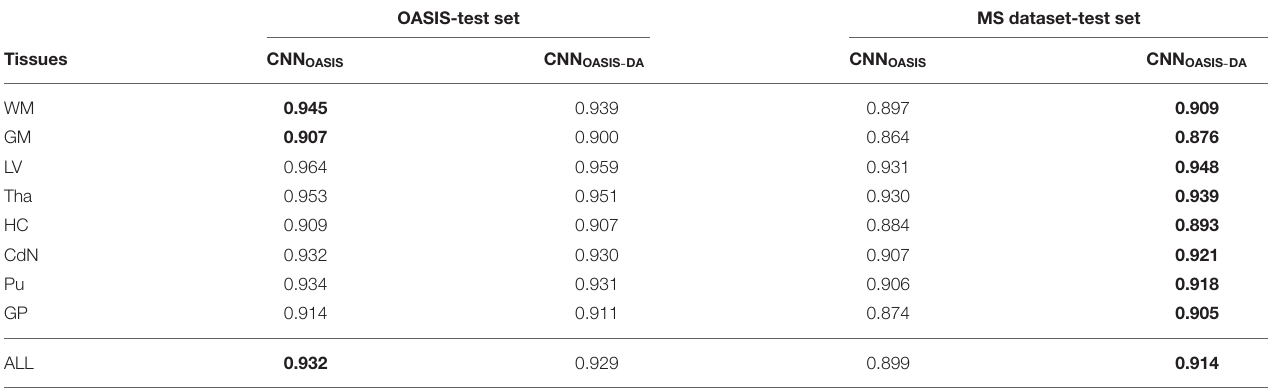
TABLE 2 | Summary of the Dice score (DC) performance of models trained on the OASIS data (CNN OASIS and CNN OASIS - DA ) and tested on the OASIS and MS dataset test sets. OASIS-test set MS dataset-test